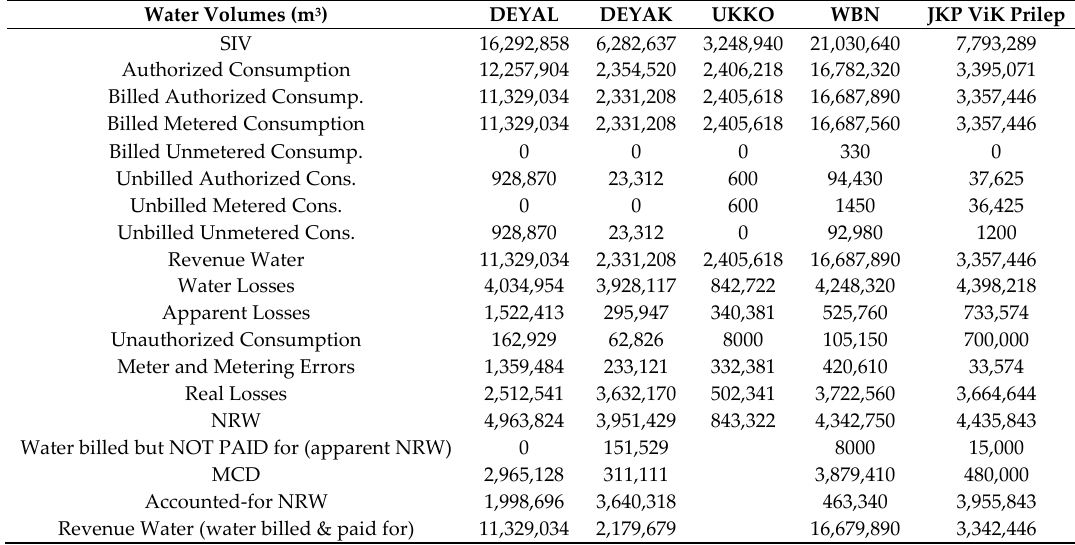
Table 3. Water Balance components in water utilities.